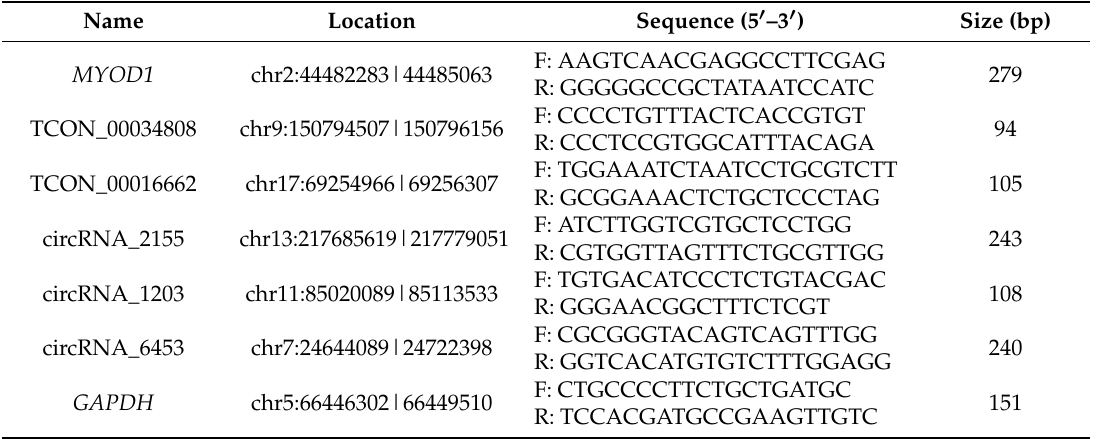
Table 1. The primers used for the validation of circRNAs and their expression trends in different